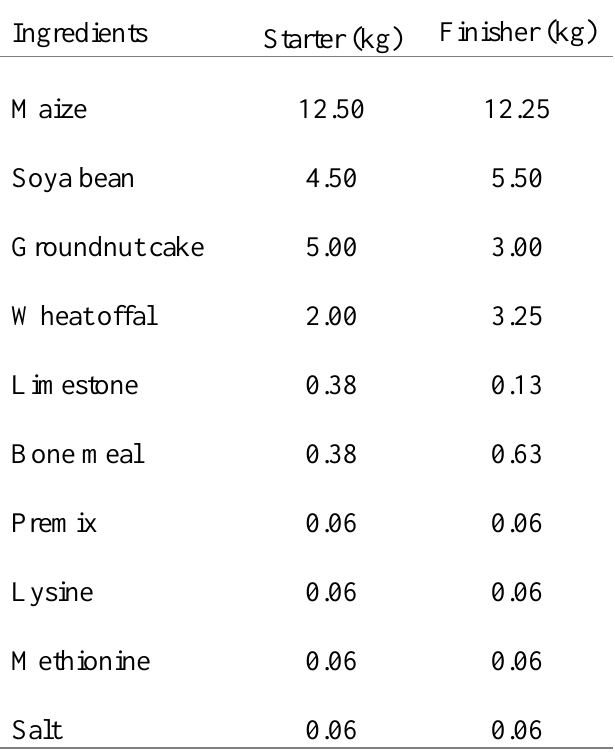
Table 1: Composition of experimental broiler starter and finisher diet for